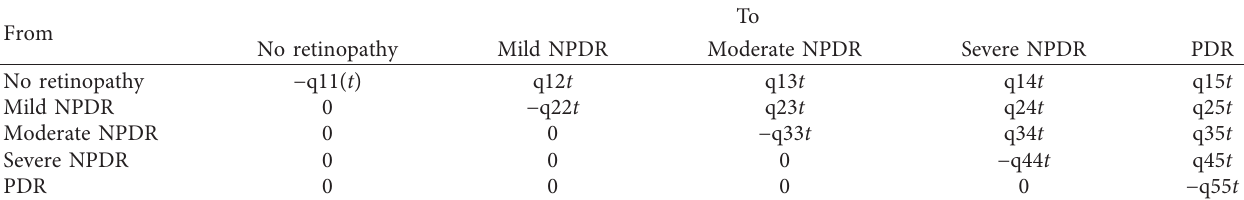
Table 1: Transition rate matrix at time t of the 5-state